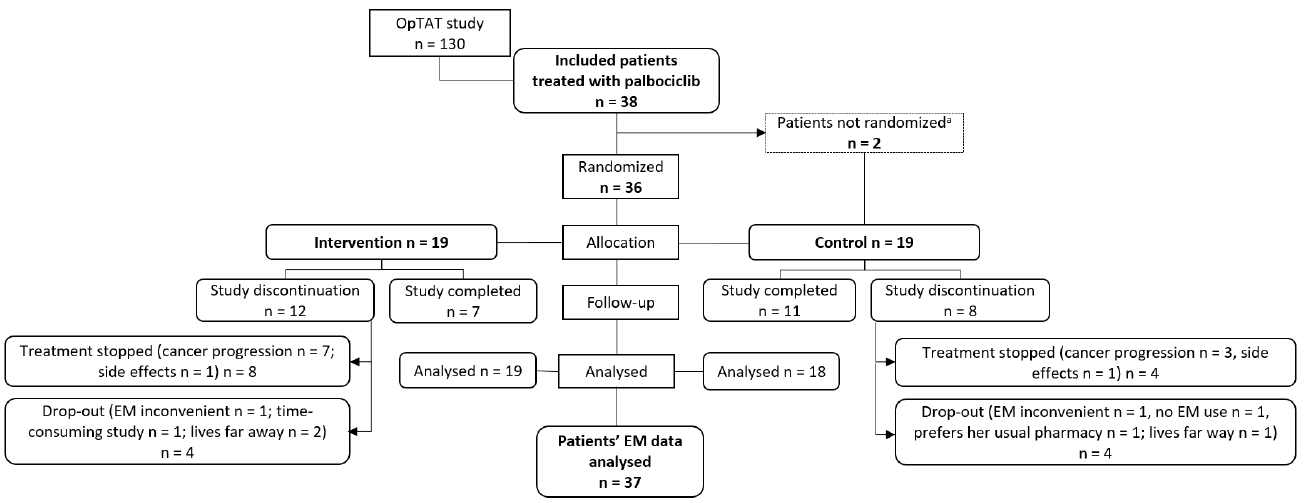
Figure 1. Flow of patient enrollment and follow up from inclusion to data analysis. a study discontinuation before randomization ; NB: EM = electronic monitor.